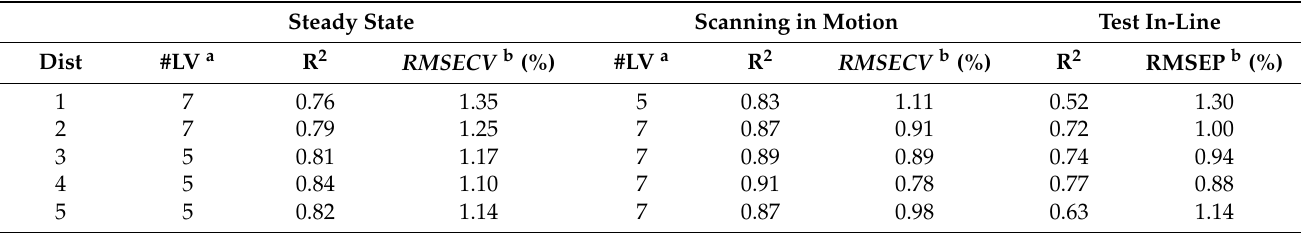
Table 2. Calibration results for potatoes measured in steady state and in motion for different distances between illuminated region and area of detection. Results for test samples are based on calibrations for potatoes in motion.